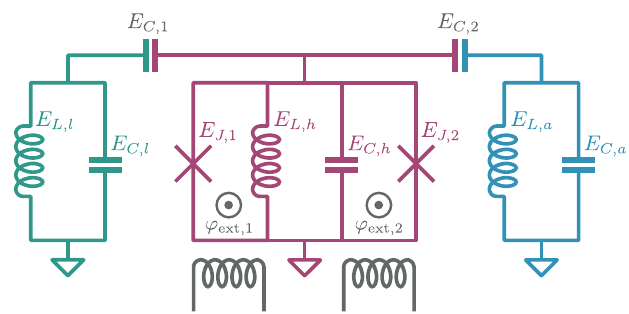
FIG. 17. Equivalent circuit diagram of the experimental proposition of Fig. 12. The cat-qubit LC resonator (blue) is capacitively coupled to the ATS circuit element (magenta), itself capacitively coupled to the low- Q buffer LC resonator